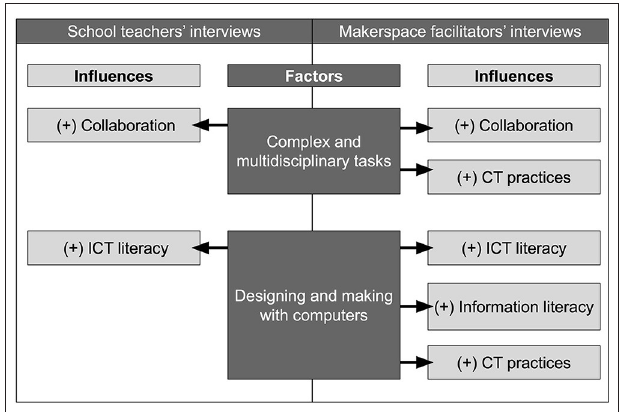
Factor 2: Designing and making with computers